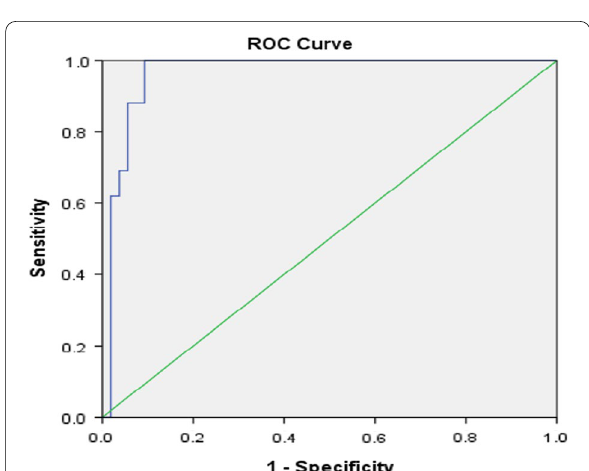
Fig. 1 ROC curve for ADC value as a diagnostic tool for